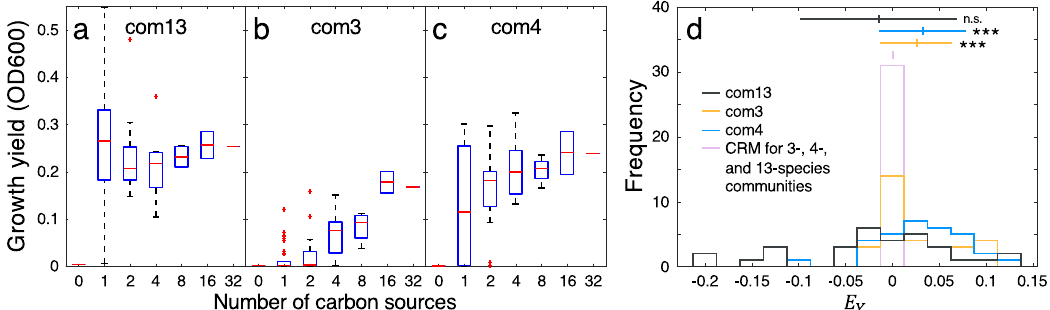
Fig. 2 Changes in community growth yield in response to environmental complexity. a – c Growth yields for com13 ( a ), com3 ( b ), and com4 ( c ) measured at the experimental endpoint (6 passages at 48-h frequencies, Supplementary Table 5). Here, the central mark indicates the median, the top and bottom box edges indicate the 25th and 75th percentiles, respectively, the whiskers extend to the most extreme points not considered outliers, and the red ‘ + ’ symbols indicate outliers plotted individually. Sample sizes are outlined in Supplementary Table 3. d Distribution of yield epistasis E Y for all three communities and simulated communities predicted using a consumer resource model (CRM). E Y distributions for each community were compared against those of statistical ensembles of CRM-simulated communities containing the same number of initial organisms (i.e., 13, 3, or 4, Supplementary Fig. 5a, e, i). Here, histograms for the simulated communities completely overlap, so they are represented as a single peak. Upper bars denote mean and standard deviation. Signi fi cance levels are calculated between each community distribution and that of the CRM using a paired one-sided t -test, and are indicated by (***) p < 0.001 ( p = 0.84 for com13, 3.6 × 10 − 4 for com3, and 2.1 × 10 − 4 for com4). Source data are provided as a Source Data fi